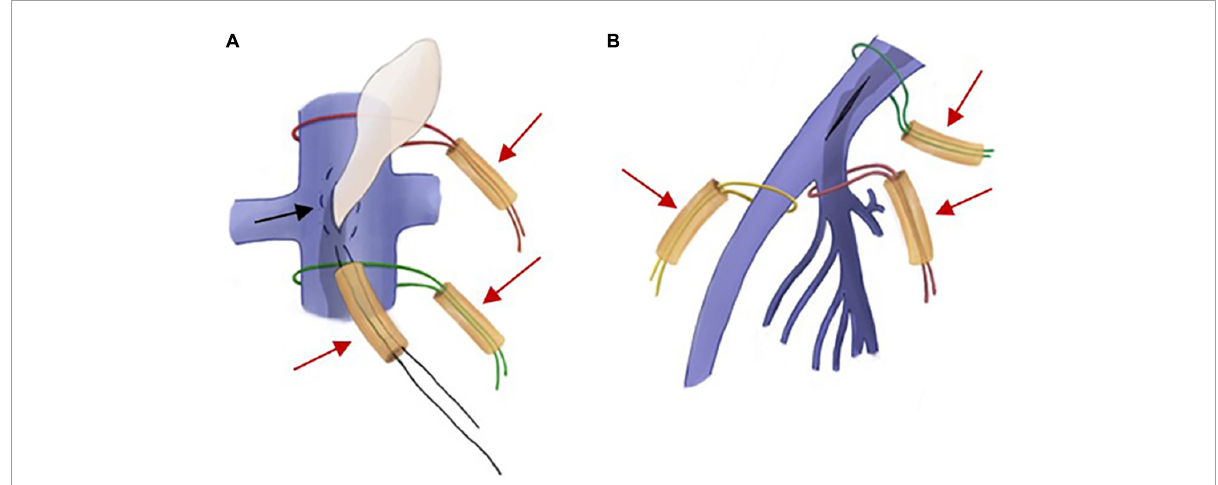
FIGURE3 Intraoperative schematic diagram of two different ways of blocking blood flow. (A) If the incision is in the inferior vena cava (IVC), a purse-string suture (black arrow) is placed between the proximal and distal blocking bands (red arrow), and the tumor can be dragged out through the incision within the suture. (B) If the incision is in the iliac vein, separate blocks are made in the common iliac vein (CIV), the internal iliac vein (IIV), and the external iliac vein (EIV) (red